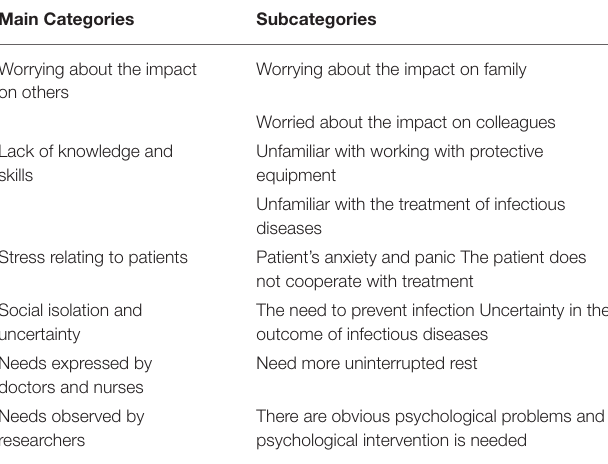
TABLE 2 | Main concepts and subconcepts of the difficulties and mental health intervention need of doctors and nurses during the COVID-19 outbreak. Main